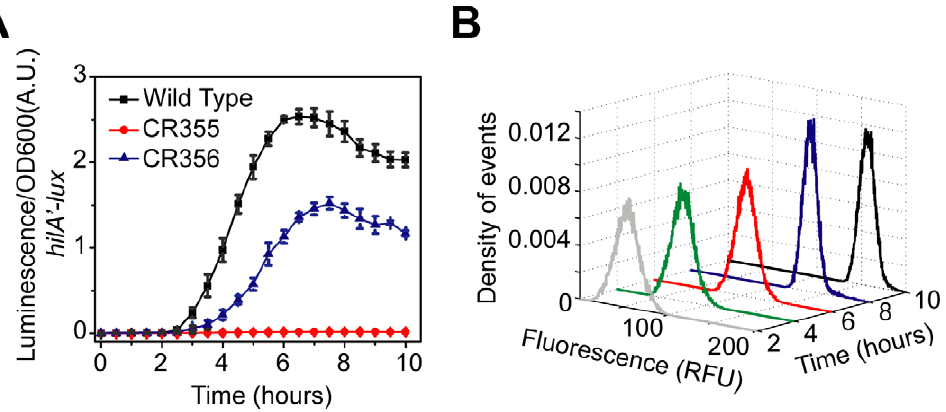
Figure 7. Rewiring SPI1 gene circuits demonstrates that HilE imposes threshold on activation. (A) Comparison of time-course dynamics for P hilA (pSS077) promoter activities in wild type (black), CR355 ( D P hilD ::P hilC D hilC , red) and CR356 ( D P hilD ::P hilC D hilC D hilE , blue) as determined using luciferase transcriptional reporters. In strain CR355, the P hilD promoter was replaced with the P hilC promoter in an otherwise D hilC background. In this strain, hilD is transcriptionally regulated in a manner identical to hilC . Strain CR356 is the same as CR355 except that it lacks HilE. (B) Dynamics of P hilA promoter activity in CR356 as determined using green fluorescent protein (GFP) transcriptional fusions and flow cytometry. Note that the activation of the P hilA promoter in CR356 is no longer switch-like but rather rheostatic in nature. Similar dynamics are seen with the P hilC promoter ( Figure S2C ). Experiments were performed as described in Figure 1